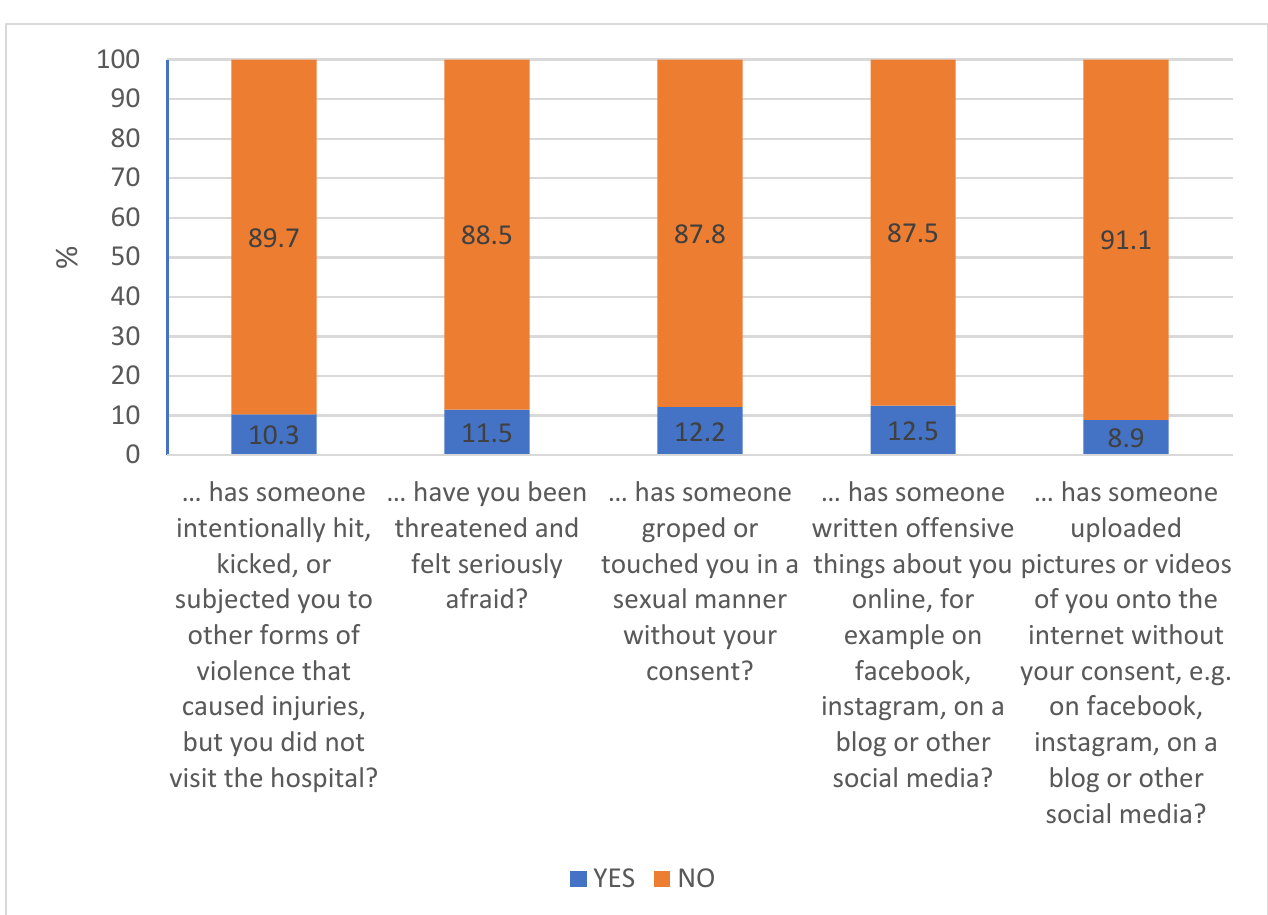
Figure 5. Presence of victimization during the past 12 months in the global study population. Physical assault and defamation were reported by a significantly larger proportion of male than female adolescents ( p < 0.001; OR = 1.83, CI = 1.55–2.16 and p = 0.004, OR = 1.31, CI = 1.09–1.56, respectively). On the other hand, a significantly larger proportion of female than male students reported that someone had groped or touched them in a sexual manner without their consent ( p < 0.001; OR = 1.77, CI = 1.48–2.11). To measure if and how the COVID-19 restrictions impacted the frequency of the different types of offenses against adolescents, they were asked to report if these types of occurrences had been happening to them more often since the COVID-19 outbreak. Around 15% of the adolescents reported a change in the frequency of the different types of victimizations. The proportion of adolescents reporting a decrease in the occur- rence of physical (14.3%) or sexual assault (14.7%), online abuse (13.1%), threats (13.5), and defamation (13.3%) since the outbreak of COVID-19 was significantly more than those reporting an increase in these events (Figure 6). Female students were likelier to report an increased occurrence of physical ( p = 0.036; OR = 1.49, CI = 1.02–2.17) and sexual ( p = 0.013; OR = 1.49, CI = 1.08–2.04) assaults and threats ( p = 0.002; OR = 1.56, CI = 1.17–2.07) in their lives since the COVID-19 outbreak. A higher proportion of students with a non-binary gender had reported changes generally and an increase of being victimized; however, the few numbers of non-binary gender students were not representative for statistical